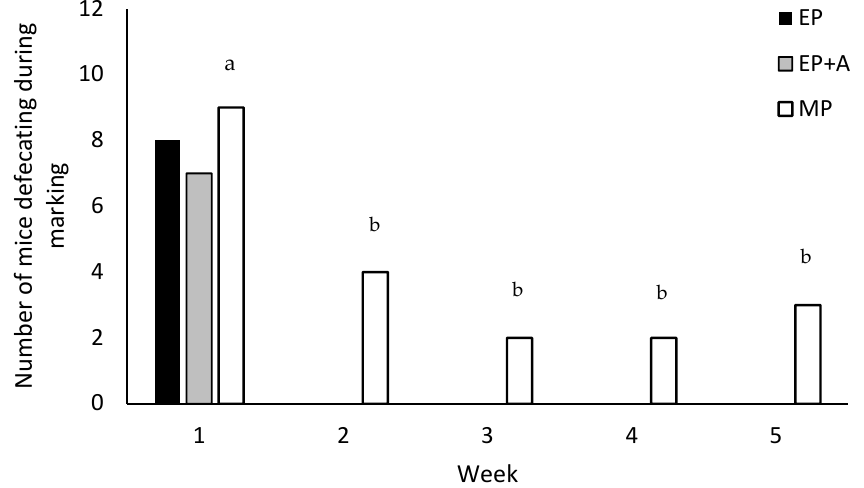
Figure 2. The number of mice defecating during different methods of identification marking. The treatments ( n = 12) were as follows: EP = ear-punch; EP+A = ear-punch plus anaesthetic cream; MP = permanent marker on the tail. EP and EP+A was only conducted once per mouse, but MP was repeated weekly. MP mice were significantly more likely to defecate at a first application than at b subsequent applications ( p < 0.001).